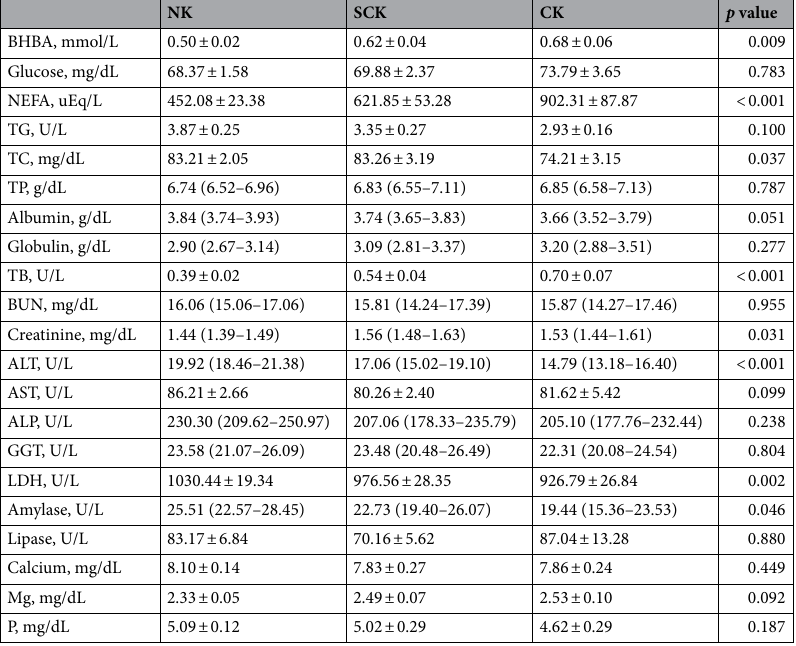
Table 3. Serum biochemistry and mineral levels by each group. Data obtained using one-way ANOVA are expressed as mean (95% confidence interval), and data obtained using the Kruskal–Wallis test are expressed as mean ± standard error of the mean. BHBA, β-hydroxybutyrate; NEFA, non-esterified fatty acids; TG, triglyceride; TC, total cholesterol; TP, total protein; TB, total bilirubin; ALT, alanine transaminase; AST, aspartate transaminase; ALP alkaline, phosphatase; GGT, γ-glutamyl transferase; LDH, lactate dehydrogenase; BUN, blood urea nitrogen; Mg, magnesium; P, inorganic